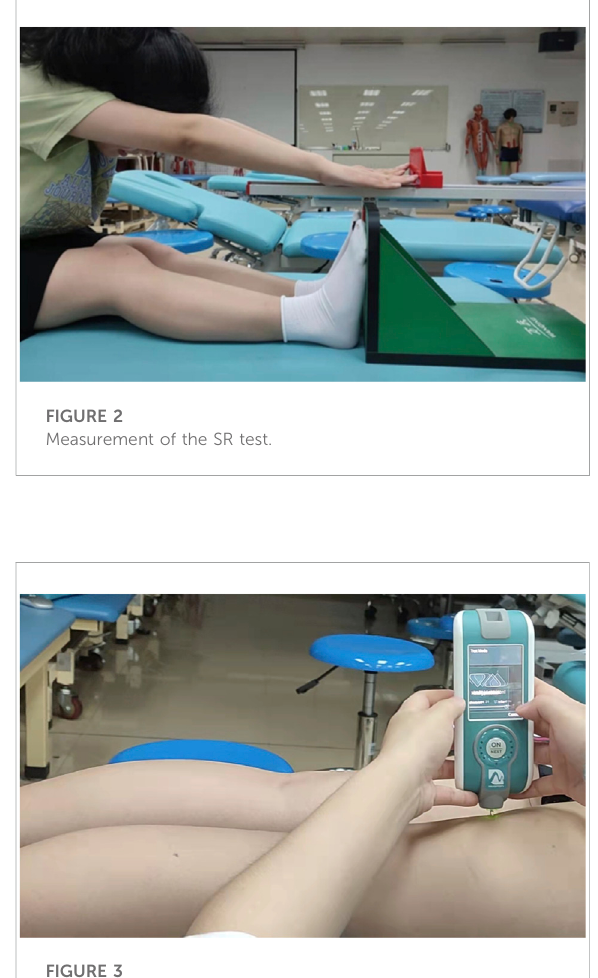
FIGURE 3 Measurement of muscle stiffness using MyotonPRO.